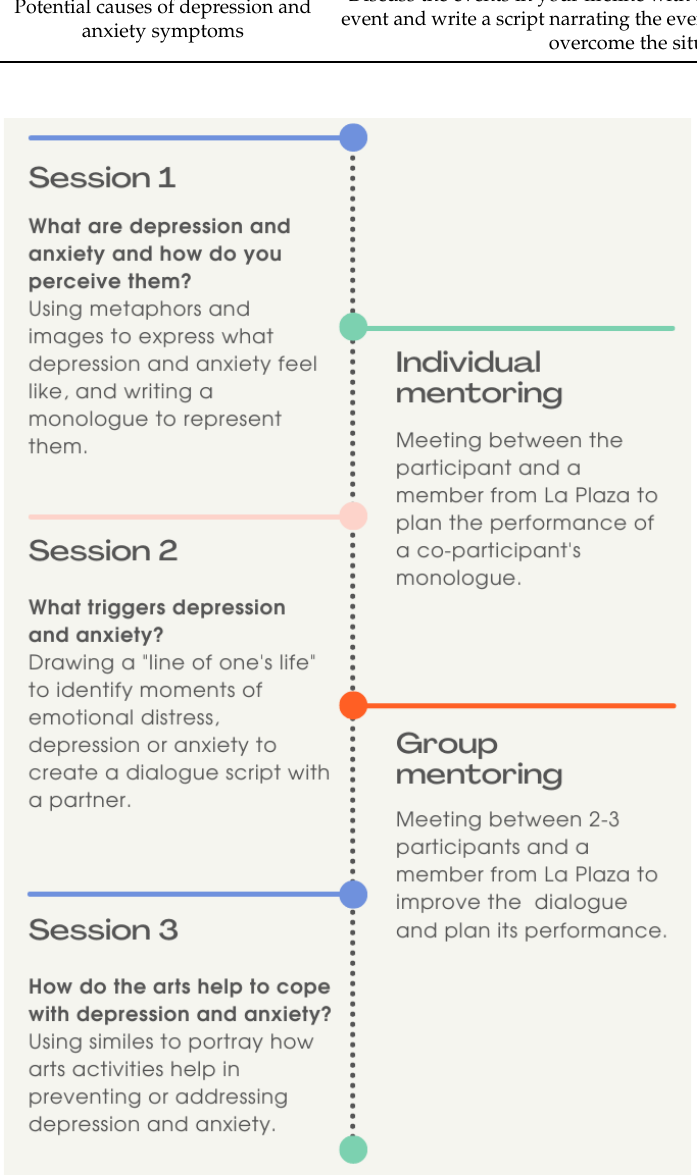
Figure 1. Outline of the dramaturgy-based